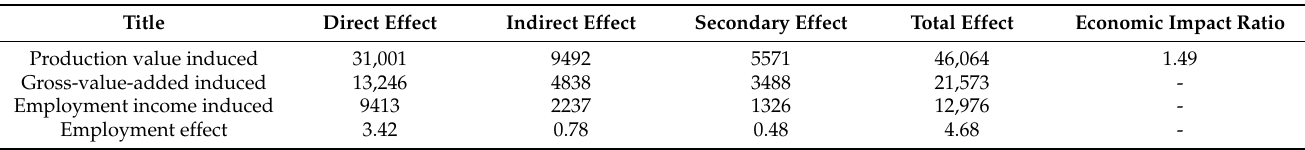
Table 10. Economic impact (in thousands of yen or in people) of the construction of a concrete dam and issuing a premium voucher.